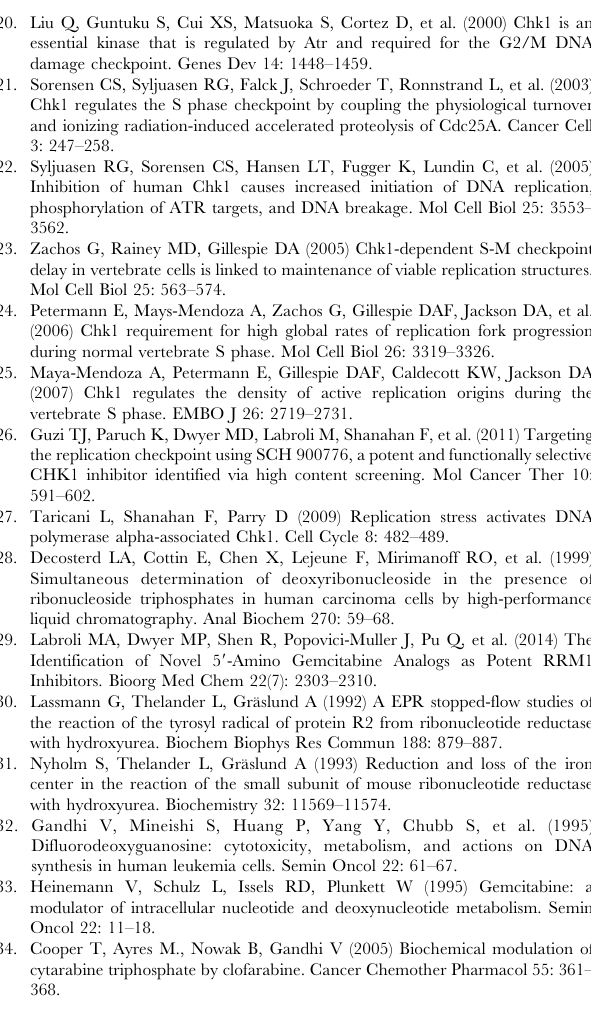
Figure S3 Chk1 depletion not co-depletion of Chk1/ Chk2 enhances the accumulation of DNA damage in U2OS cells. (TIF) Figure S4 Chk1 interacts with RRM1 subunit of Ribo- nucleotide reductase in CEM cells. (TIF) Table S1 Identification of Chk1 interacting of potential Chk1 interacting proteins in proteomic screen. (DOCX) Materials and Methods S1 Generation of Recombinant Adenoviruses, Adenovirus Infections and Immunopre- cipitation of Chk1-Flag, SDS-PAGE Separation and In- Gel Digestion, Mass Spectrometry Analysis of Proteins Spots, and